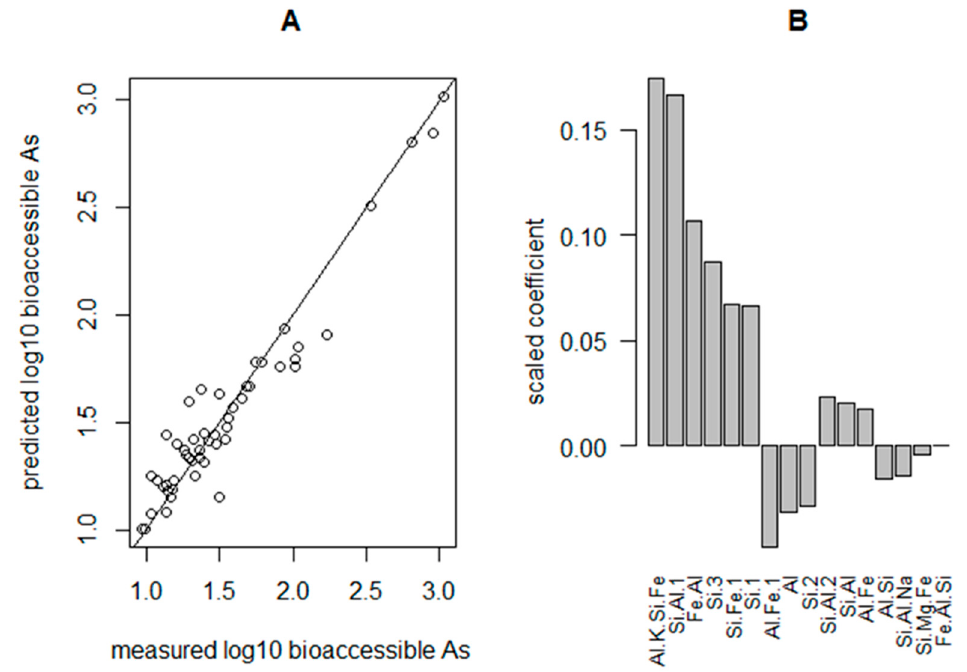
Figure 9. Lasso regression model data for bioaccessible As ( A )—predicted bioaccessible As vs measured bioaccessible As with line of equivalence. ( B )—Relative magnitude of lasso chosen ISC coefficients.